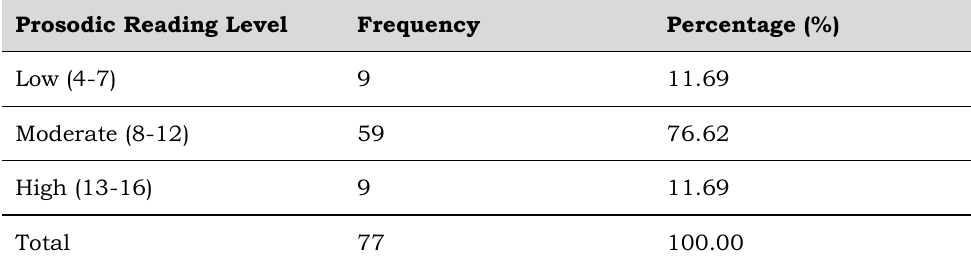
Table 2. Students’ prosodic reading percentage